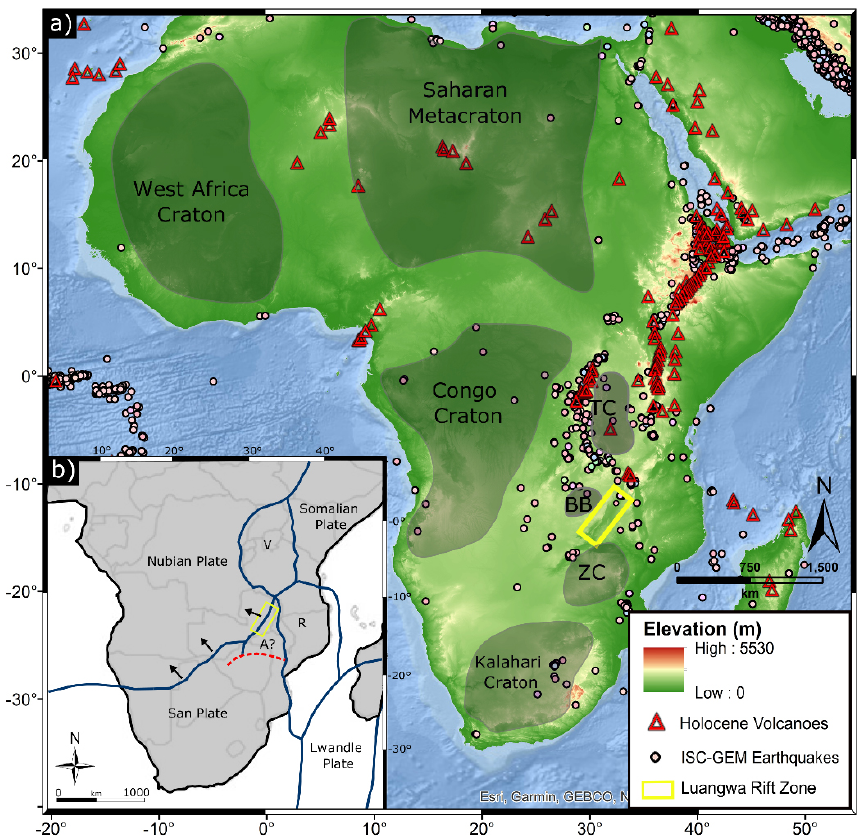
Figure 1. The seismicity, volcanism, and plate boundaries of the EARS. (a) Seismotectonic map that highlights the topography of the African continent, the locations of Archean cratons (adapted from Gubanov and Mooney, 2009), and the prevalence of earthquakes in the Proterozoic belts surrounding the cratons. TC – Tanzania Craton, ZC – Zimbabwe Craton, BB – Bangweulu Block. Holocene active volcanoes are represented by red triangles and earthquake epicentres by circles from the ISC-GEM catalogue. The Luangwa Rift is highlighted in yellow. (b) Plate configuration of southern Africa including the Victoria (V), Rovuma (R), Lwandle, and San microplates (Calais et al., 2006; Stamps et al., 2008; Wedmore et al., 2021) and the model proposed by Daly et al. (2020) where the Angoni microplate (A) is separate from San. The black arrows are vectors of the Nubian plate with respect to San, which are fault- and earthquake-defined (Daly et al.,